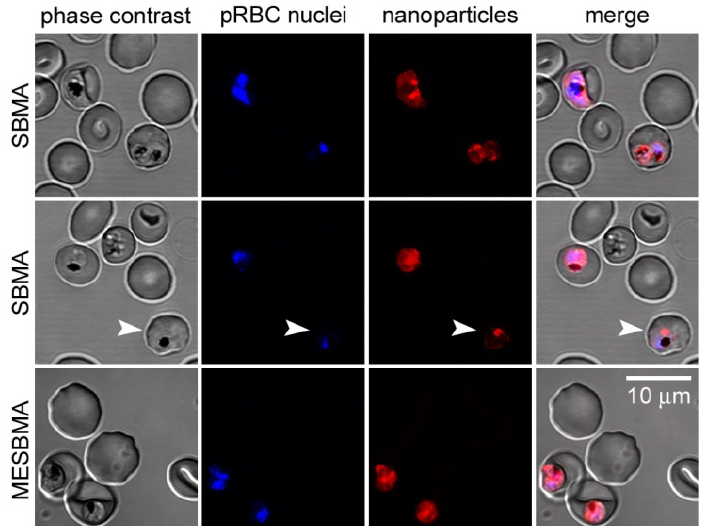
Figure 6. Confocal fluorescence microscopy analysis of the interaction of curcumin-containing, Cy3-labeled PBMA-SBMA and PBMA-MESBMA nanoparticles with RBCs and pRBCs. The ar- rowhead indicates an early trophozoite-stage parasite. Reproduced with permission from [173], Elsevier B. V., 2021. Because the key component of NCs is the drug to be administered, it is essential that new candidates enter the pipeline of medicines against malaria, as these will be the active molecules of future delivery systems. It is necessary to fully characterize the mechanism